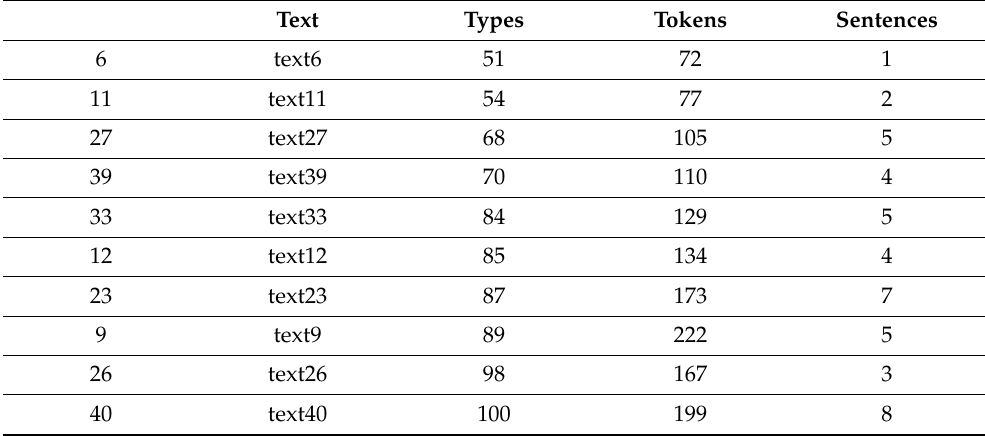
Table 3. Partial view of tokens, types and sentences of 41 texts of the dataset, sorted by decreasing order of types.